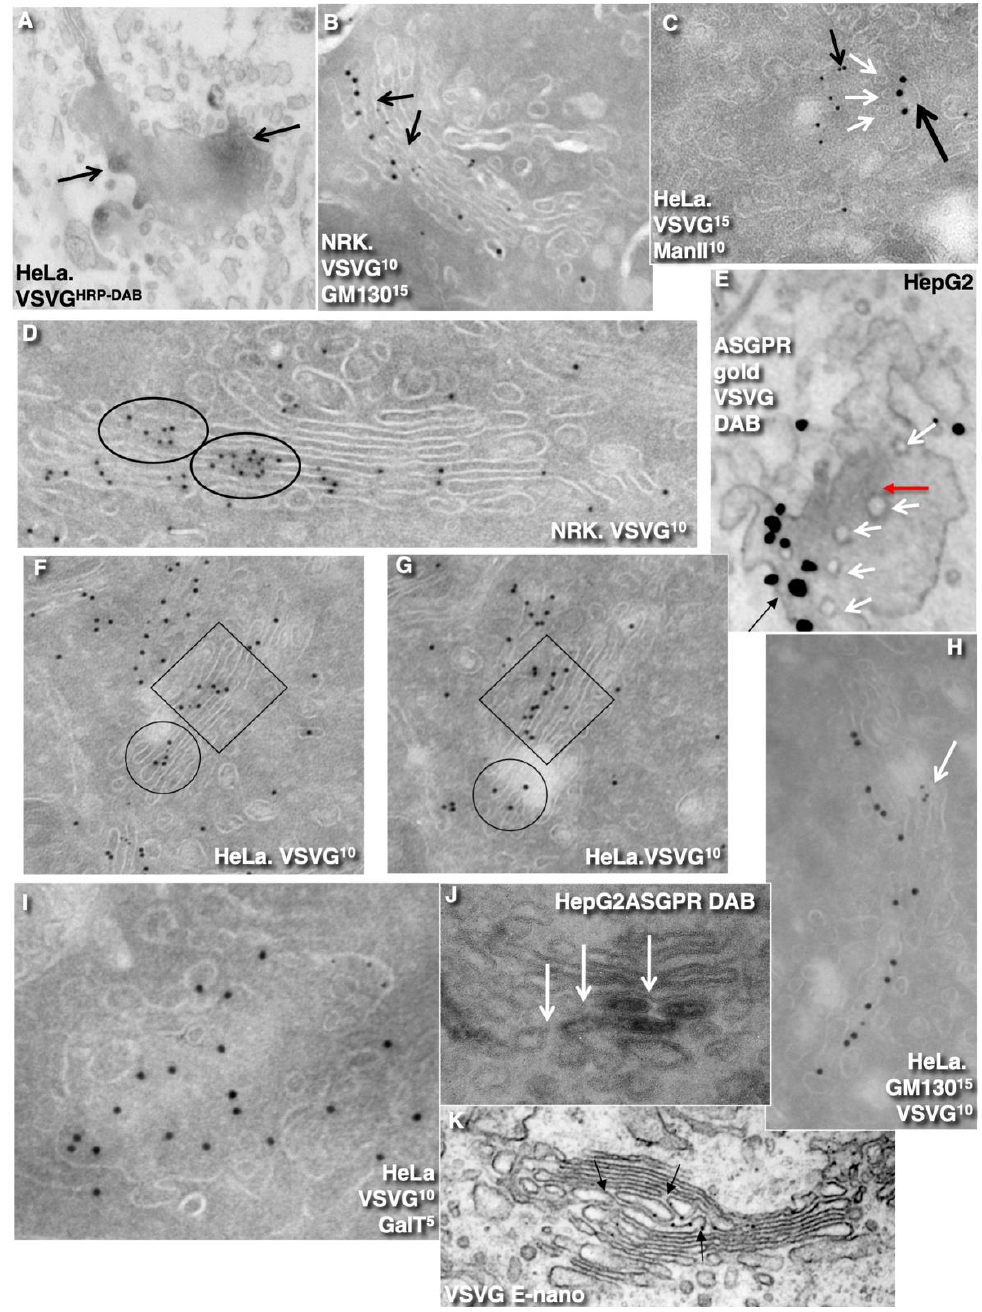
Figure 6. During intra-Golgi transport of small amounts of VSVG and ASGPR (CHM-15-CHM protocol), their distinct domains are formed. ( A , E , J ) HRP-DAB reaction. ( B – D , F – I ) Tokuyasu cryo-sections. ( F , G ) Serial Tokuyasu cryo-sections. ( E , K ) Enhanced-nanogold. ( A – I , K ) Domains of VSVG and ASGPR ( E , J ) at 5 min after release of the transport block. Clusters (arrows) of 10-nm gold particles as indication of VSVG domains along the Golgi stacks. ( C ) Domains of VSVG (large black arrow) and ManII (small black arrows). White arrows indicate pores around VSVG domain. ( E ) Domains of ASGPR (gold; black arrow) and VSVG DAB (red arrow) are distinct. White arrows indicate pores around cargo domains. ( J ) Domain of ASGPR (DAB labelling) is surrounded with pores (white arrows). Markers and gold size are indicated on images. Circles and squares indicate VSVG domains. Scale bars: 280 nm ( F – L ); 200 nm ( M , Q ).